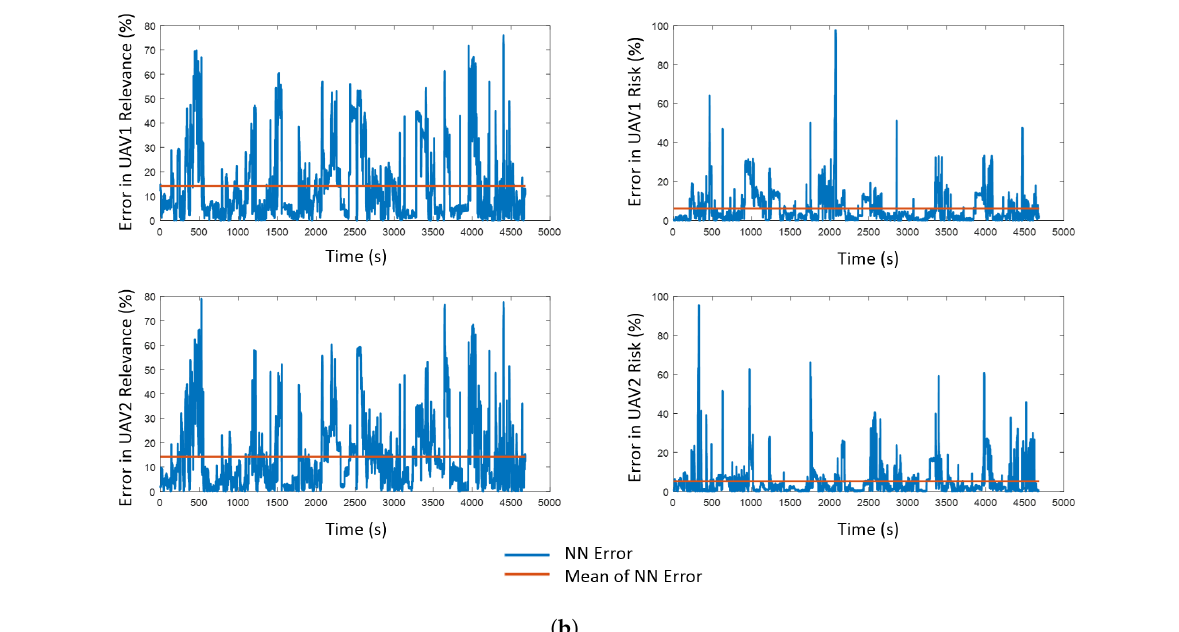
Figure 5. Evaluation of operator vs. prediction of neural networks. ( a ) Direct comparison; ( b ) Absolute error and mean value.